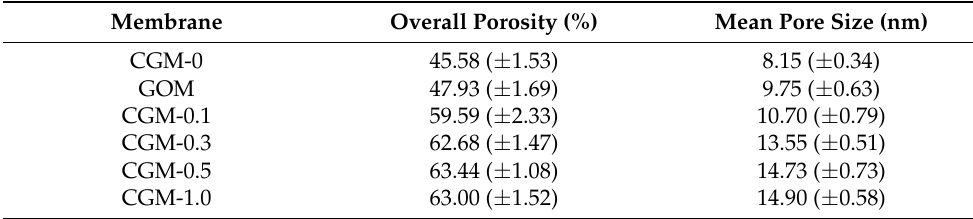
Table 3. Porosity and average pore size of different ultrafiltration membranes.